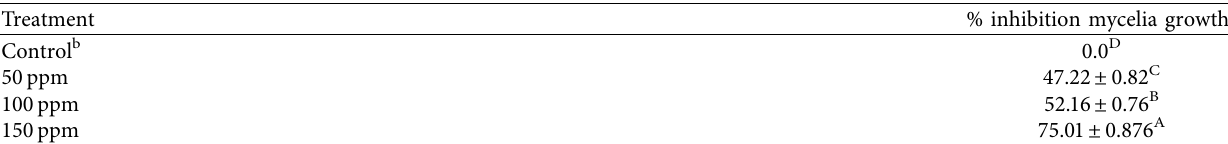
Figure 6: (a) Size distribution. (b) Zeta potential distribution of AgNPs synthesized using B. lanzan Spreng leaf extract. Table 1: Antifungal activity of AgNPs on in vitro mycelial growth of Rhizoctonia solani .